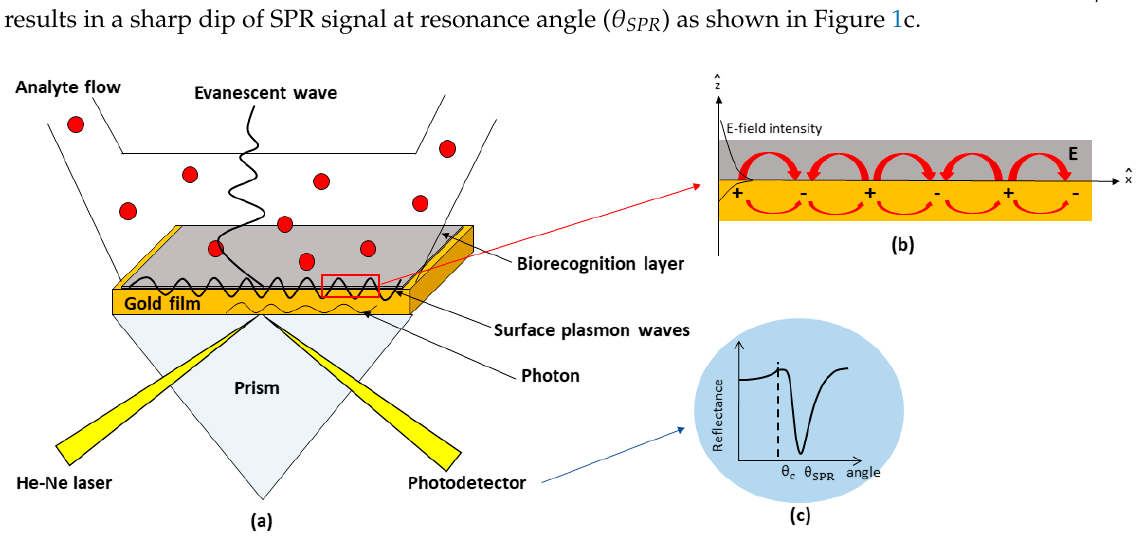
Figure 1. Schematic diagram of the detection-based SPR technique. ( a ) Surface plasmon waves; ( b ) Electric field components; ( c ) SPR resonance angle.